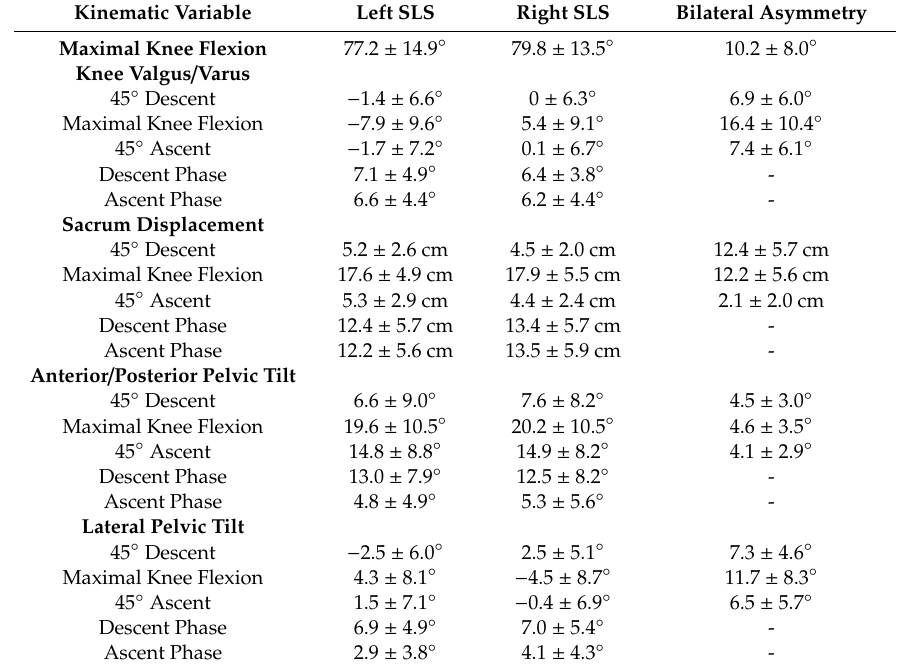
Table 1. Means and Standard Deviations of Single-leg squat Kinematics at Each Event and across Each Phase.